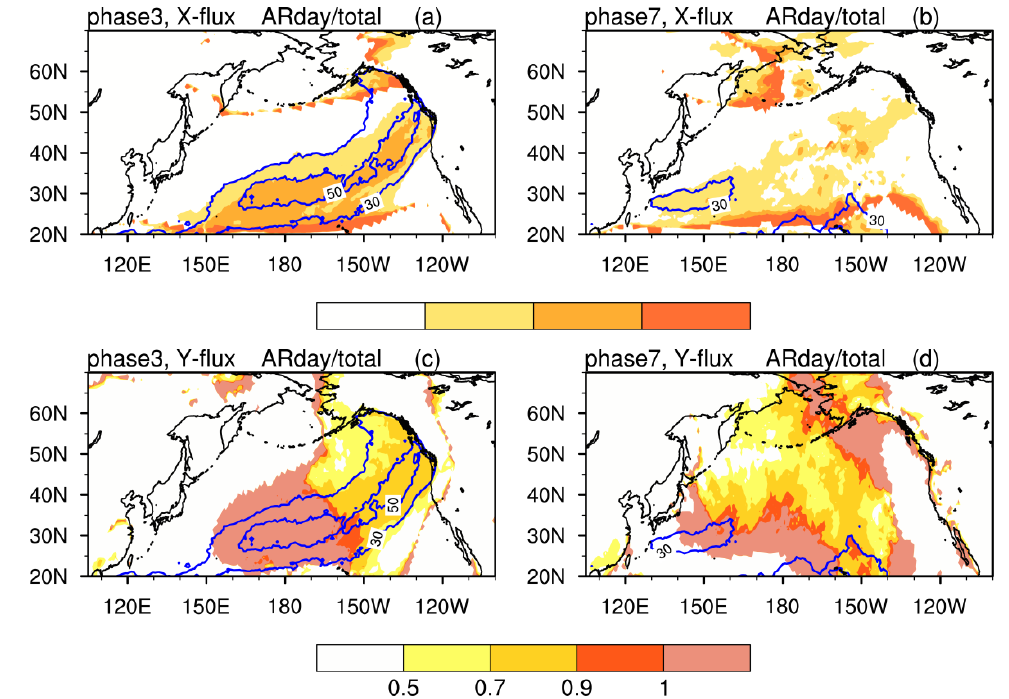
Figure 7. Upper panel: composite fields of ratio of the zonal component of IVT (IVT-X) for the group of AR days to IVT-X for total days. Lower panel: composite fields of ratio of the meridional component of IVT (IVT-Y) for the group of AR days to IVT-Y for total days. ( a ) and ( c ) for phase three, and ( b ) and ( d ) for phase seven. Blue contours indicate the AR frequency of 30% and 50% in their individual phases.